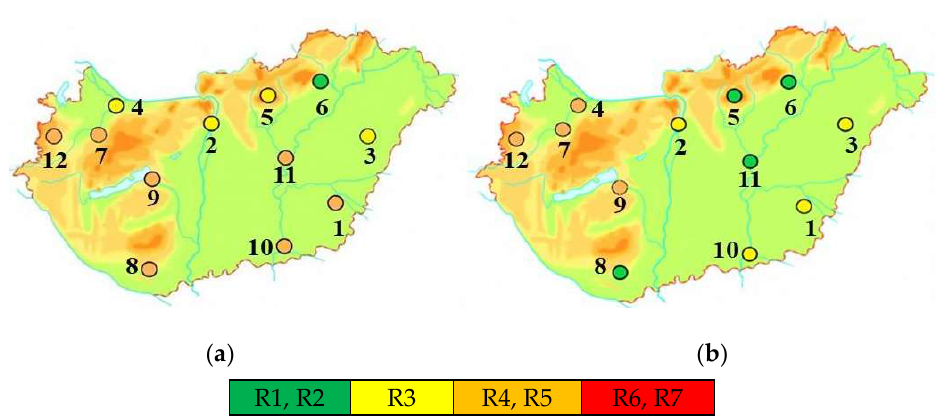
Figure 11. Categories of International Ice Classes [22] on Hungarian synoptic stations between ( a ) 1965–1990 and ( b ) 1991–2016. The colors represent the severity of climatically possible wet snow masses based on the international color scale of the warning system. Station labels can be seen in Table 1. The map depicts area between 15° E, 45° N (southwestern corner) and 24° E, 49° N (northeastern corner). Table 6. Comparison of Ice Classes [22].